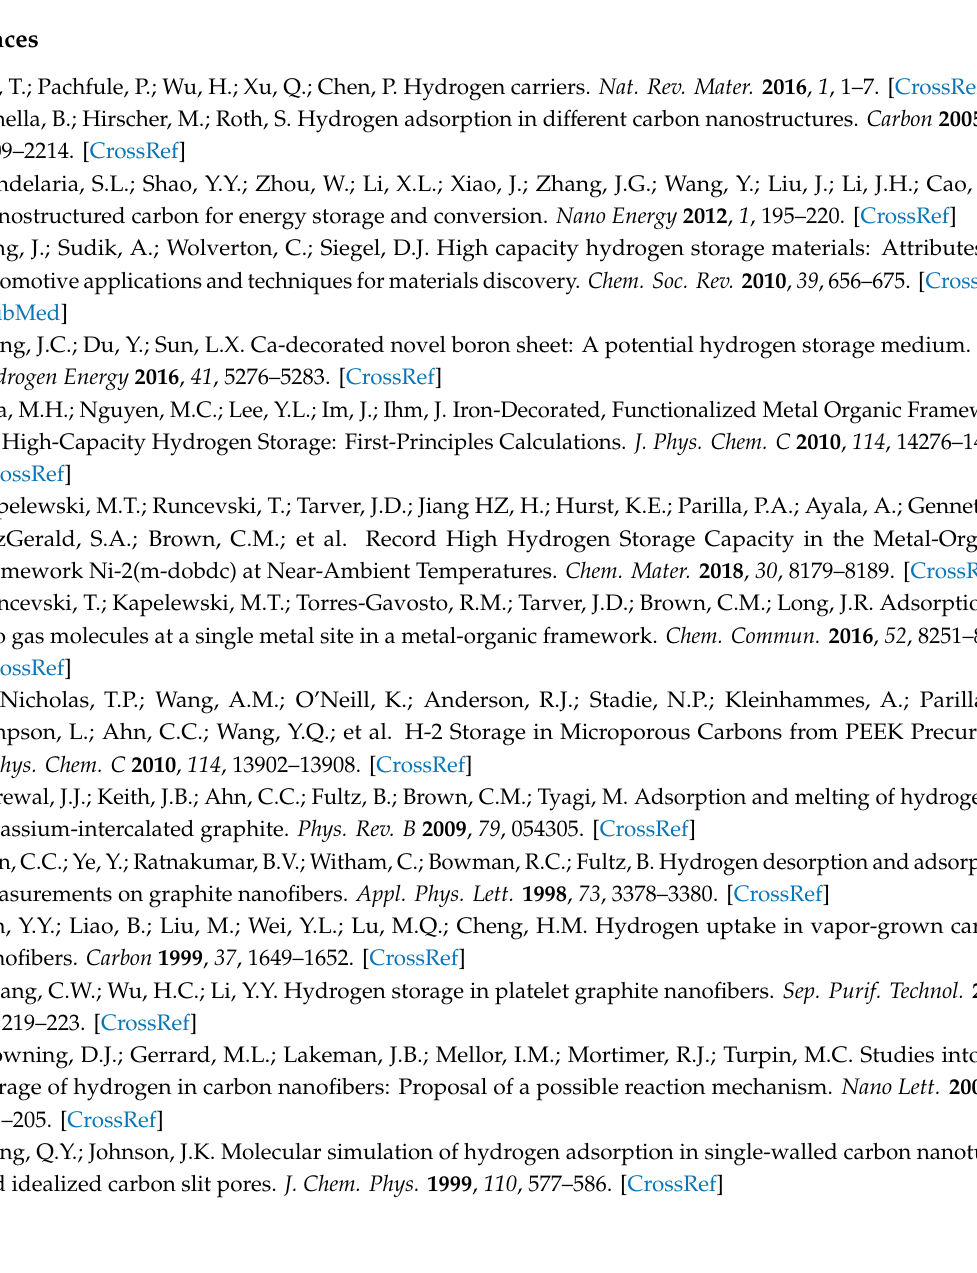
Figure S1. Binding of second H 2 molecule on the boron–doped model; Figure S2. H 2 binding of systems where boron doping is at the edge; Table S1. H 2 binding energy for di ff erent DFT exchange methods using vdW–DF1; Figure S3. Interactions sites for H 2 physi-sorption on 2% boron–doped graphene; Figure S4. Top and side view of H 2 interactions on graphene with di ff erent doping; Table S2. Absolute electronic energies for extended systems; Geometries and electronic energy for the molecular